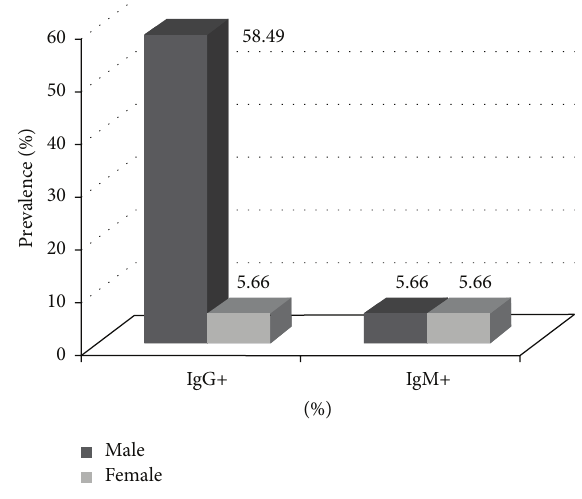
Figure 1: Distribution of Toxoplasma antibodies by gender.